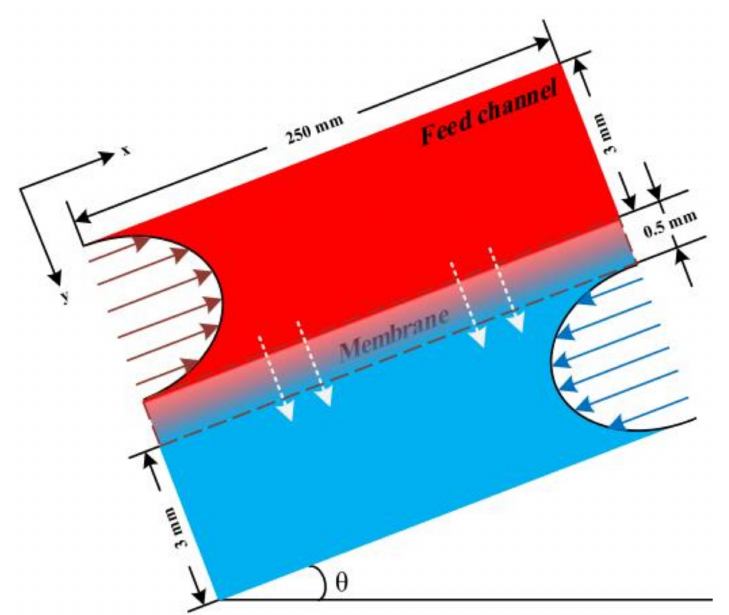
Figure 2. An illustration of the modeled direct contact membrane distillation (DCMD) unit and its geometrical